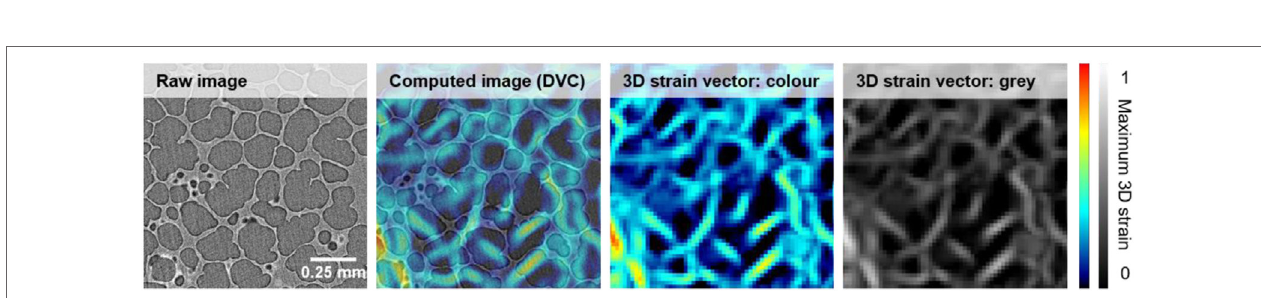
FigUre 3 | Transient pressure measured during the moderate and low-intensity blasts: (a) at outlet of the shock tube (solid line) and (B) at the top (dashed line) and bottom (dotted line) regions in front of the thorax.